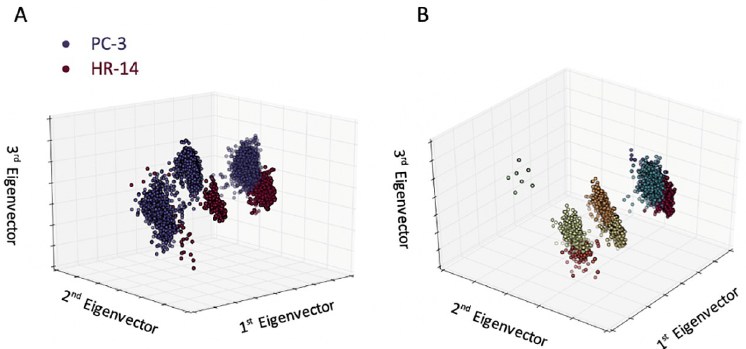
Fig 3. Unsupervised analysis of PC-3 (epithelial) and HR-14 (mesenchymal) cell lines using k-means clustering . A: The projection of PC-3 (blue) and HR-14 (red) cells onto the first three eigenvectors. Notably, when training the computer, it gets the information about each cell being either PC-13 or HR-14. Before any machine learning has been done, we can see that the two cell lines clearly cluster into distinguishable groups. Interestingly, we find that the clusters are not continuous and the emergence of morphological sub-phenotypes is apparent. B: The results of k-means clustering with the constraint that each cluster must maintain a homogeneity score greater than 0.95. We find that the constraint for highly pure clusters results in the identification of 7 sub-phenotypes.